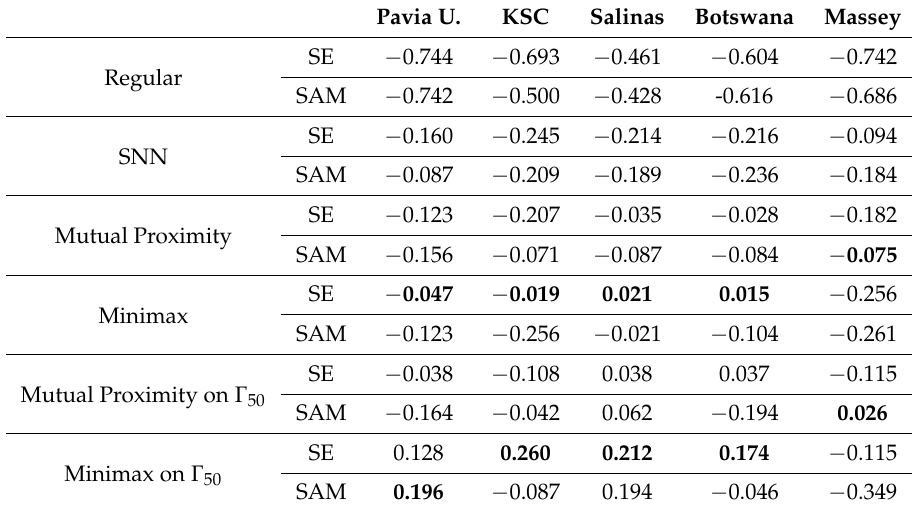
Table 1. Comparison of similarity measures in terms of average ground truth silhouette (higher is better). SE: Squared Euclidean norm, SAM: Spectral Angle